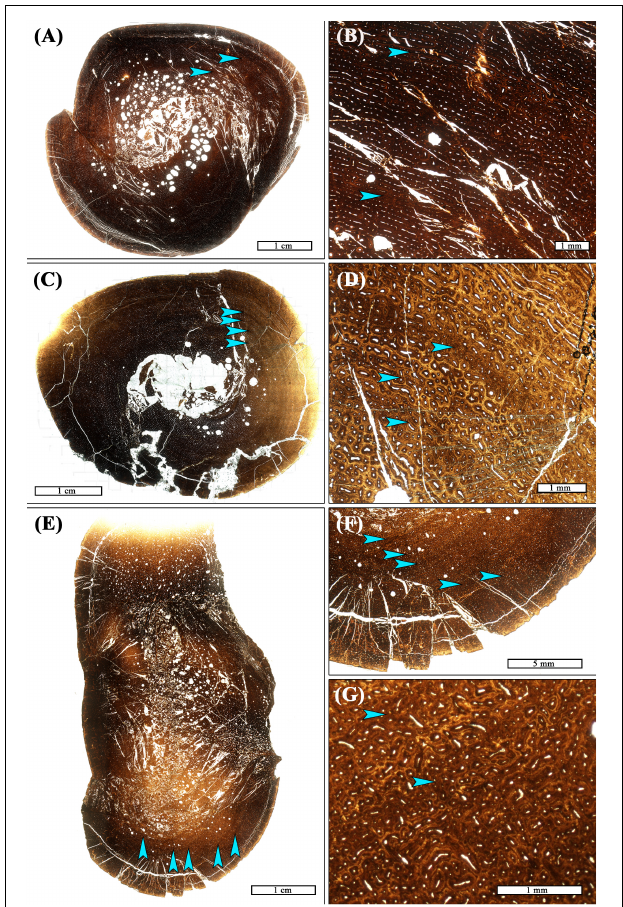
FIGURE 1 | Transverse thin sections of Maiasaura tibiae from young of the year showing variation in frequency, spacing, and composition of localized vascular changes (LVCs). (A) There are 2–3 LVCs in the tibia T12. Two are located mid-cortex (arrows), and there may have been a third in the outer cortex but it is now obscured by post-burial fragmentation of the cortex. (B) Magnification of the cortex of T12 showing the two mid-cortex LVCs (arrows). The innermost LVC is made of smaller laminar primary osteons compared to adjacent laminar primary osteons. The second LVC is of larger reticular to laminar primary osteons compared to those adjacent (C) Four LVCs (arrows) are closely spaced within the mid-cortex of tibia T01. (D) Magnification of the T01 cortex shows that all four LVCs (arrows) are made of smaller reticular primary osteons compared to adjacent reticular laminae. (E) LVCs were most numerous in tibia T29, with a total of five (arrows). (F) Magnified view of T29, with arrows highlighting location of LVCs. (G) Magnification of the cortex of T29 showing the second and third LVC. They are comprised of small longitudinal primary osteons located adjacent to larger, mostly reticular, primary osteons. All images are shown in plane polarized light.